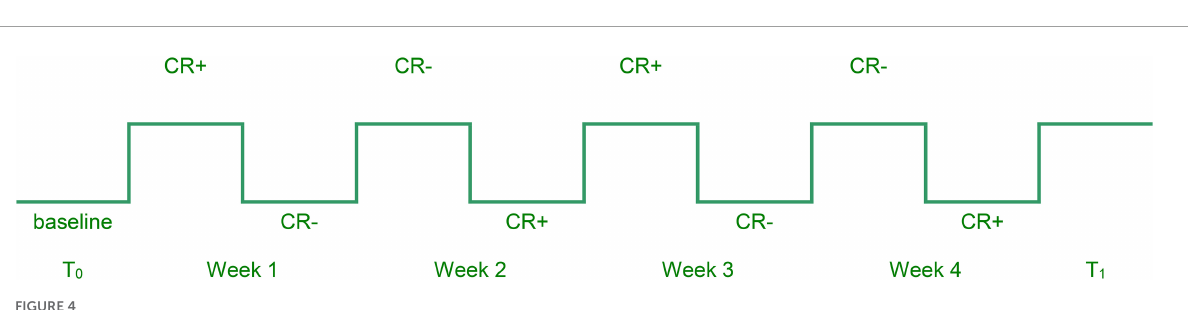
FIGURE4 CR training process: one session as an example (4 weeks, 2